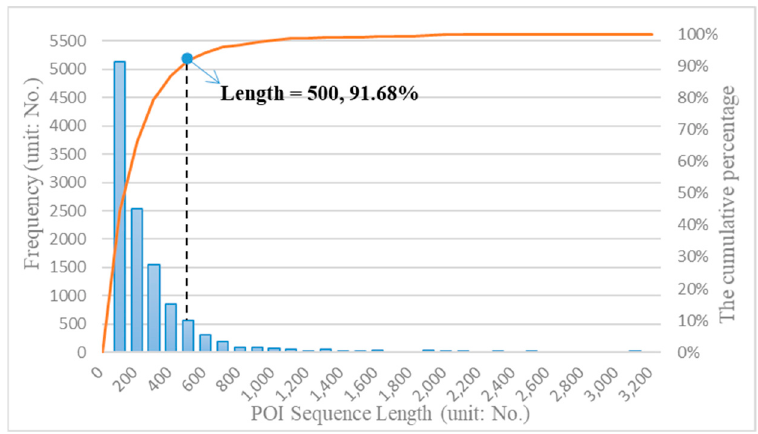
Figure 6. Distribution of POI sequence length of parcel. The POI sequence length is the number of POIs in the